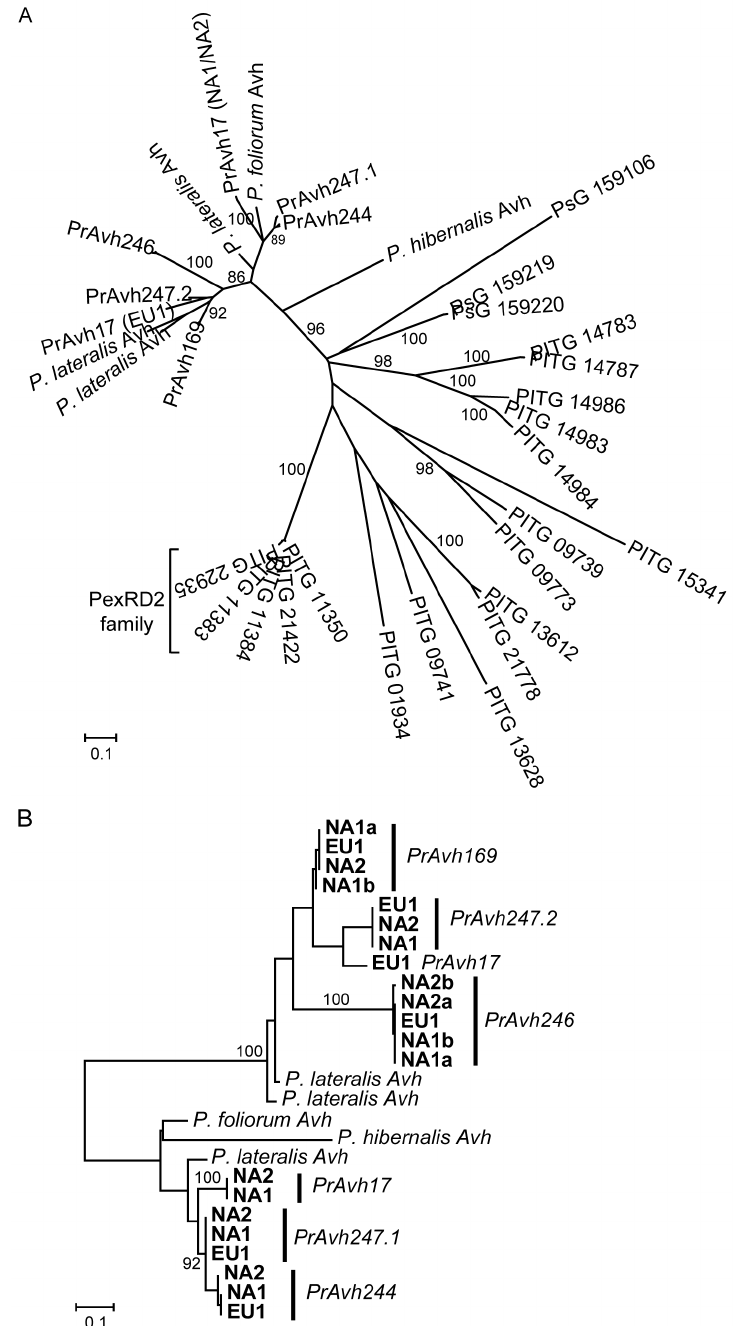
Figure 4. Relationships among orthologs and paralogs in an effector gene family with recombination. A family in P. ramorum that is orthologous to the PexRD2 family in P. infestans shows expansion and recombination in P. ramorum . A. Minimum evolution tree inferred using amino acid sequences for Haas et al.’s (2009) Fam6. This family includes the PexRD2 genes in P. infestans . Proteins from P. infestans have a PITG prefix and proteins from P. sojae a PsG prefix. Branch support is shown as a percentage of 500 bootstrap samples. The branch lengths are drawn to scale and measured in the number of substitutions per site. B. Maximum likelihood tree for nucleotide sequences representing the C-terminal region of Haas Fam6 effector genes from P. ramorum , P. lateralis , P. hibernalis , and P. foliorum indicating putative orthologous and paralogous relationships for this region. Branches with high bootstrap support, based on 500 bootstrap samples, are indicated. The branch lengths are drawn to scale and measured in the number of substitutions per site. doi: 10.1371/journal.pone.0079347.g004 PLOS ONE |